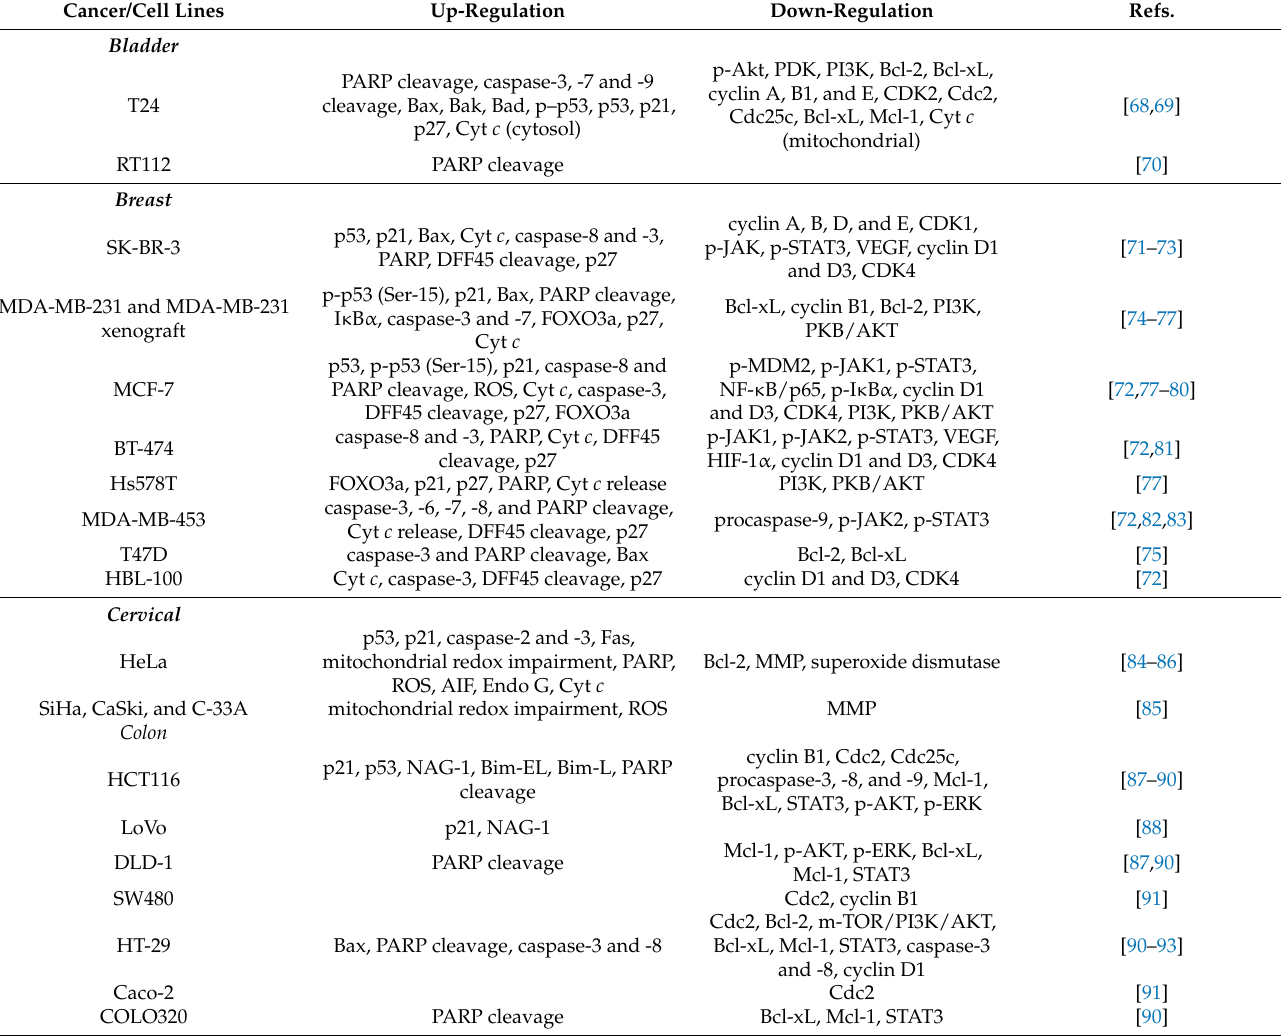
Table 1. Molecular targets of apigenin-induced